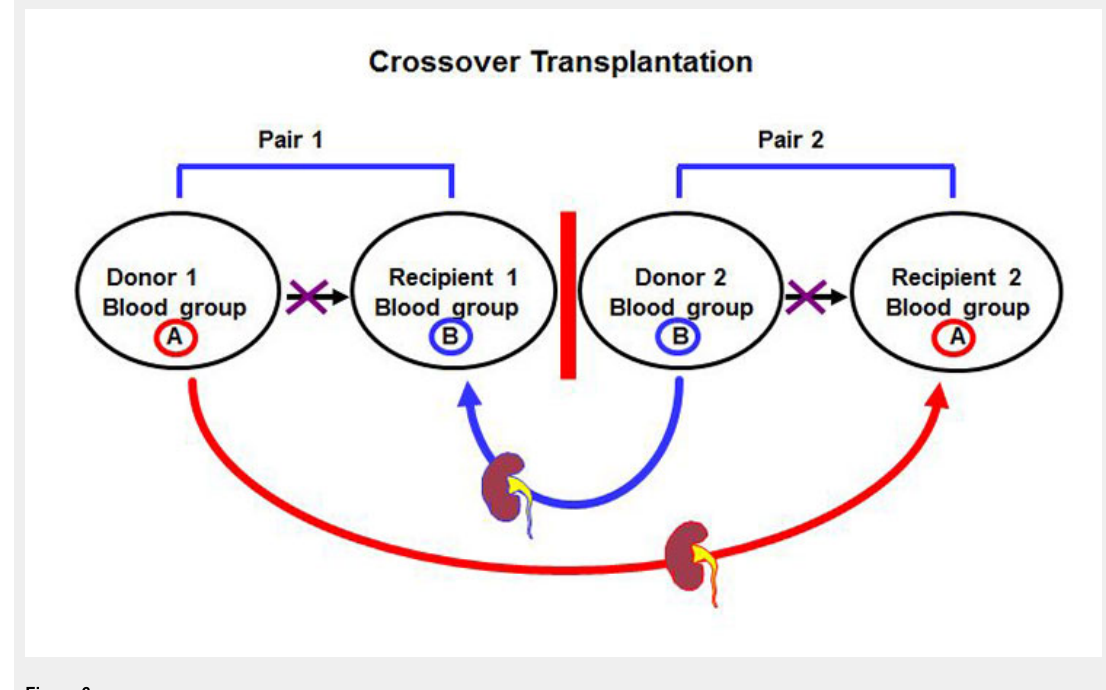
Figure 6 Principle of crossover kidney transplantation between two pairs with incompatible blood group.